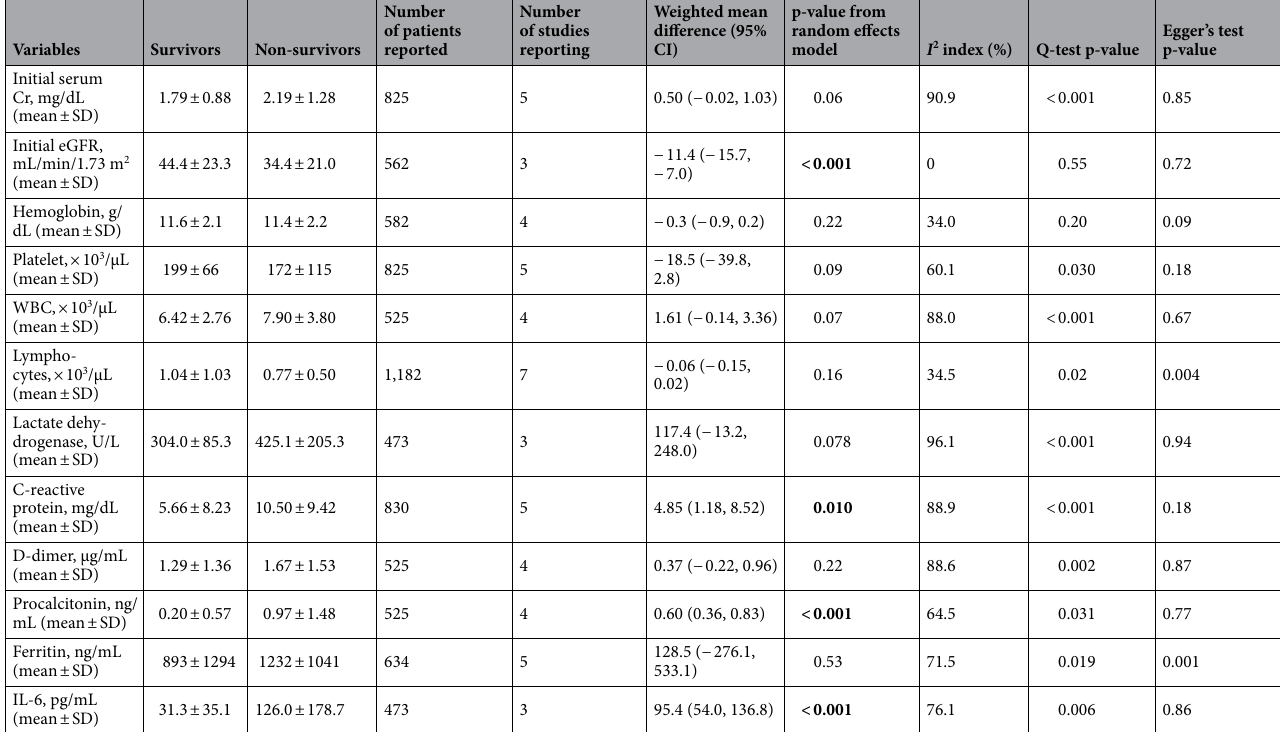
Table 3. Meta-analysis of baseline laboratory investigations between survivor and non-survivor kidney transplantation recipient. Cr creatinine, eGFR estimated glomerular filtration rate, WBC white blood cell.